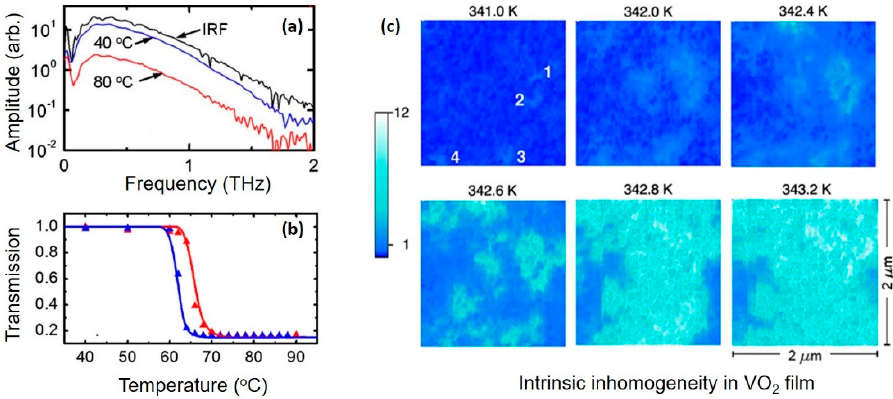
Figure 2. Modulation phenomenon in the terahertz (THz) regime. ( a ) THz transmission spectrum of VO 2 / r -sapphire sample at low (40 °C) and high (80 °C) temperatures. THz transmission through air is also shown to illustrate the instrument response function. ( b ) Normalized (to T = 40 °C) THz field amplitude transmission as a function of the temperature (symbols) for VO 2 films grown on c-sapphire. Reproduced from [90], with permission from Optical Society of America, 2012. ( c ) The near-field scattering infrared microscopy pictures over the same 2 µ m by 2 µ m area (infrared frequency ω = 930 cm − 1 ) in heating process. The spatial resolution is 15 nm. The metallic regions (light blue) give higher scattering near-field amplitude compared with the insulating phase (dark blue). Four newly formed metallic puddles are marked as 1, 2, 3 and 4 on the T = 341.0 K image. Reproduced from [93], with permission from American Physical Society, 2009.